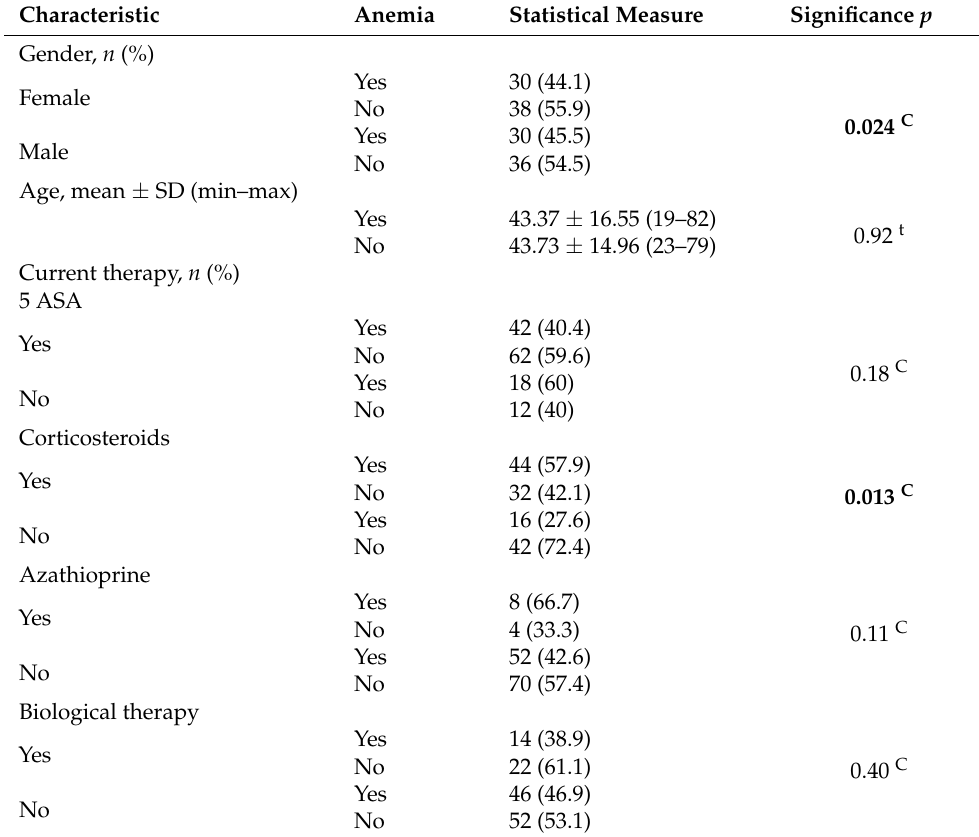
Table 2. Relationship between the clinical and demographic characteristics of CD patients and